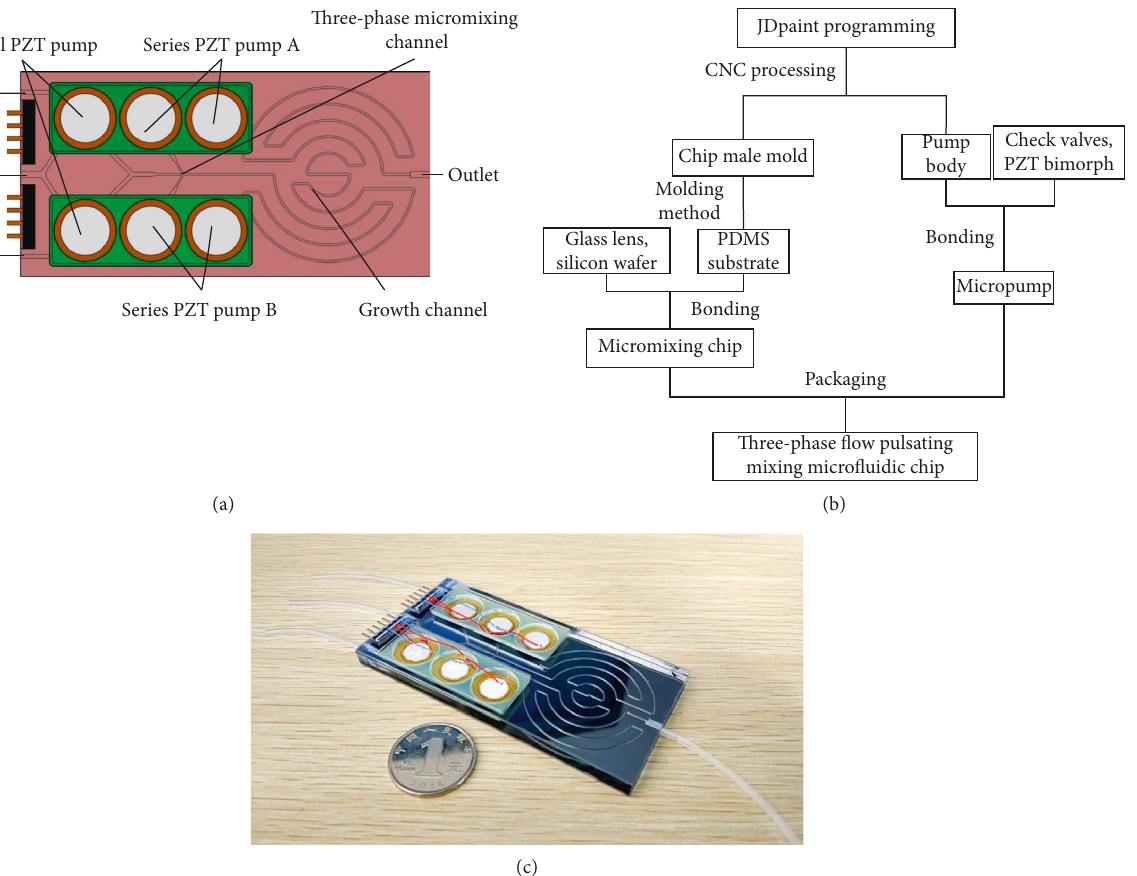
Figure 1: (a) The prototype schematic of the microfluidic chip. (b) The fabrication flowchart of microfluidic chip for three-phase flow pulsating mixing. (c) The prototype photo of the microfluidic